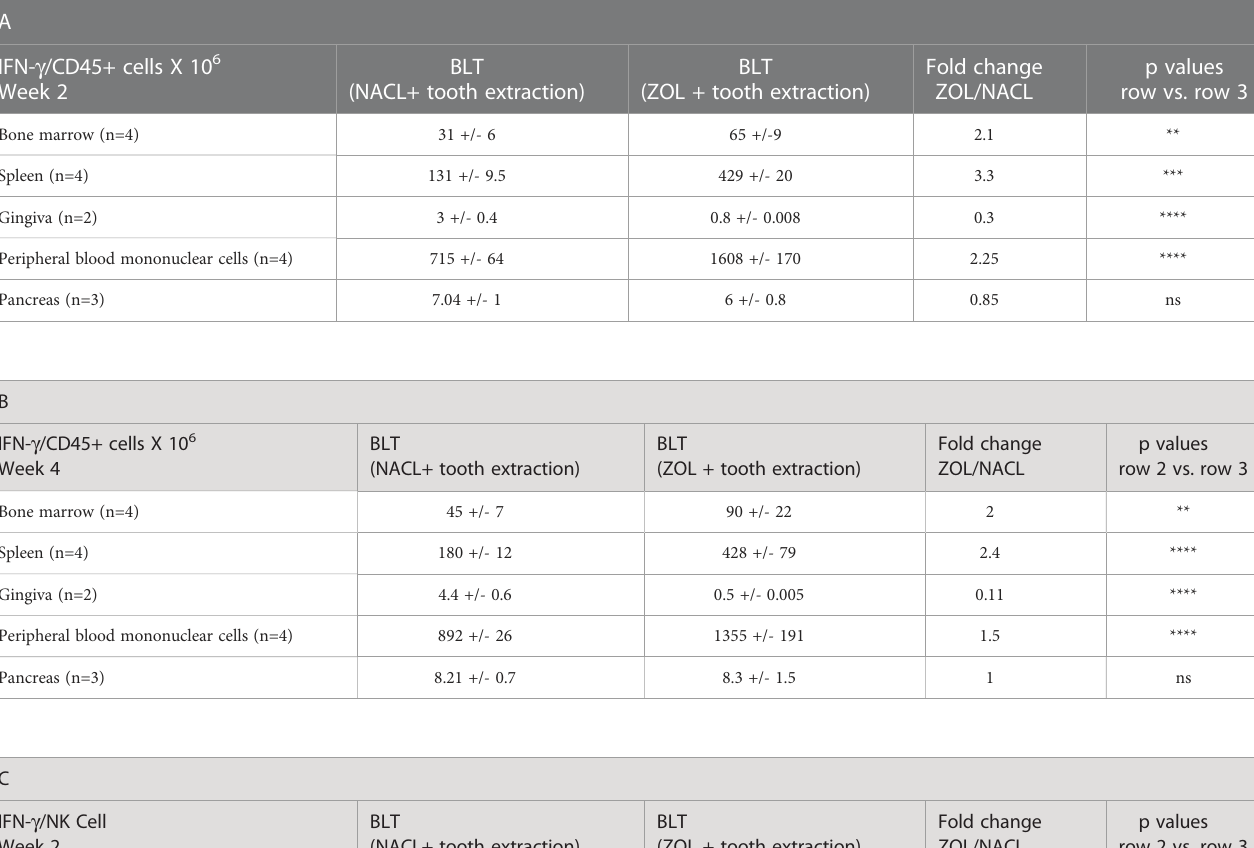
TABLE 3 IFN- g secreted per one million hu-CD45+ immune cells or per one NK cell in tissue compartments of NACL or ZOL-injected and tooth-extracted hu-BLT